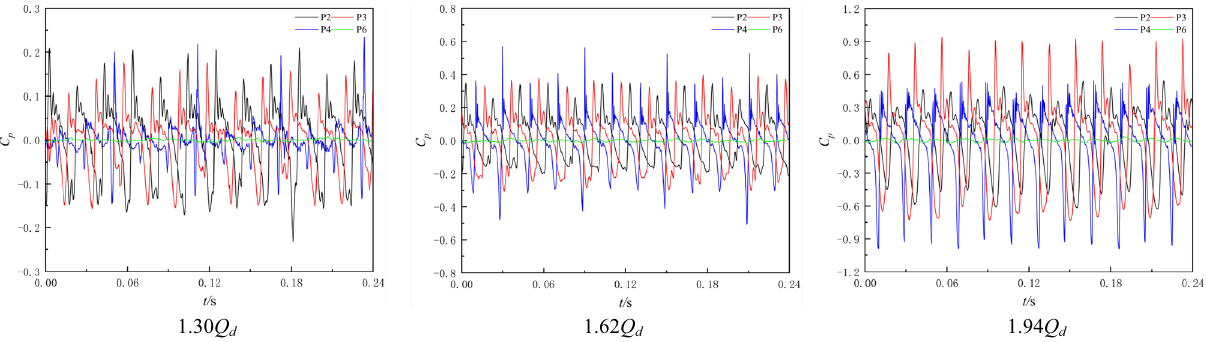
Figure 13. Time domain diagram of pressure fluctuation under the RPGC.